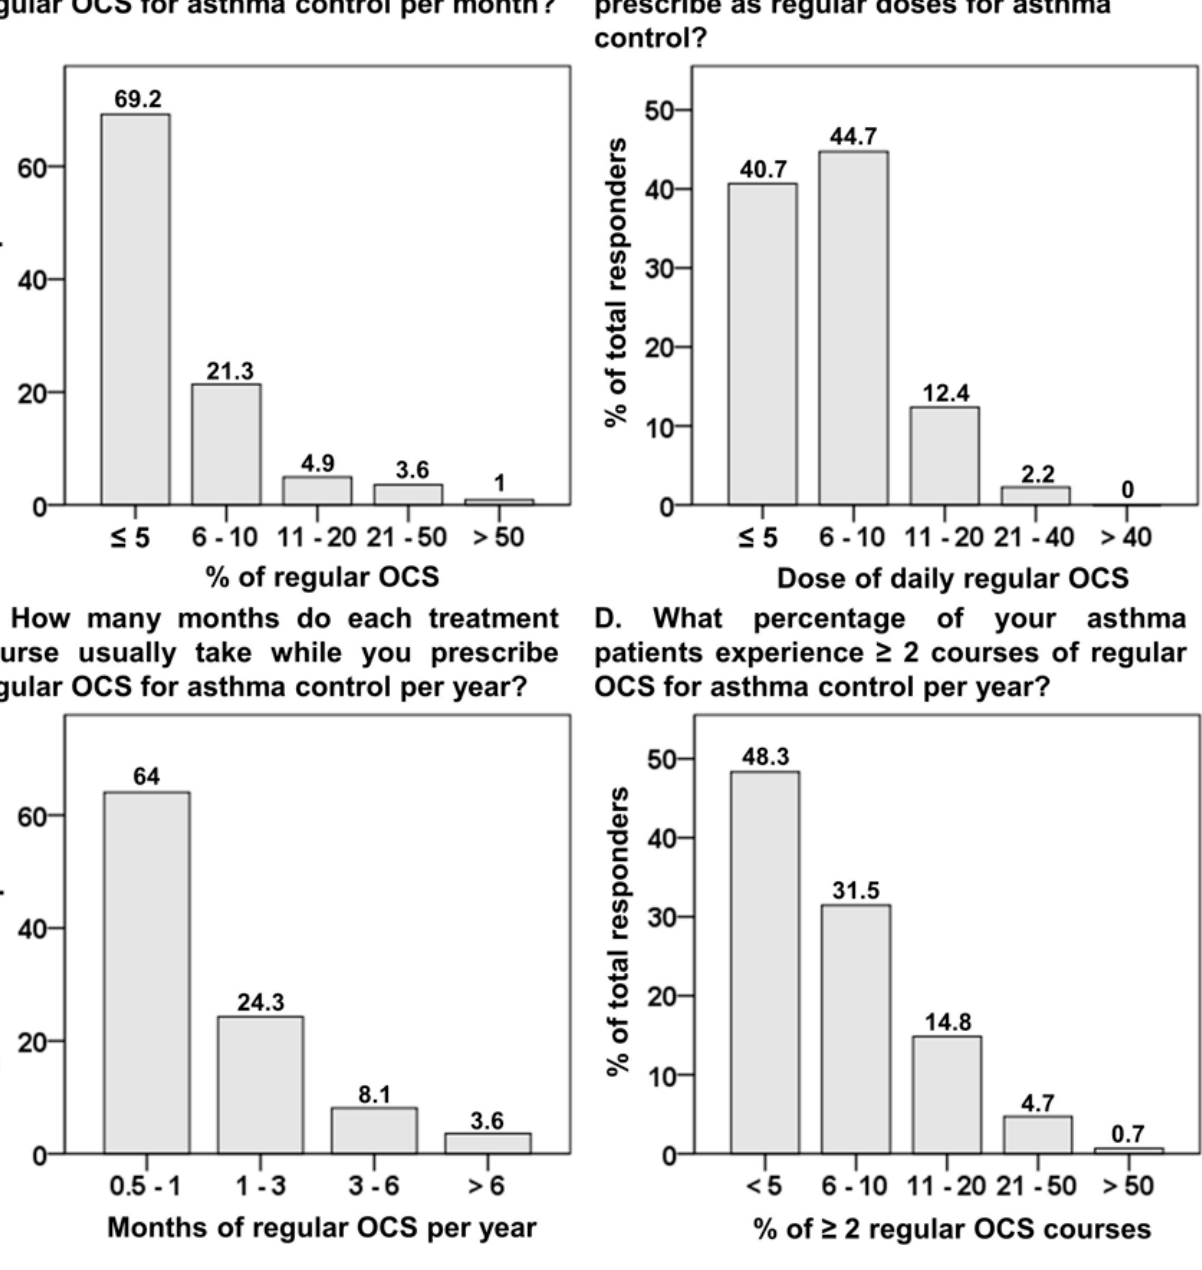
Figure 2. The proportion of responses to questions regarding regular oral corticosteroids for asthma control. OCS, oral corticosteroid. * Indicates prednisone or equivalent in